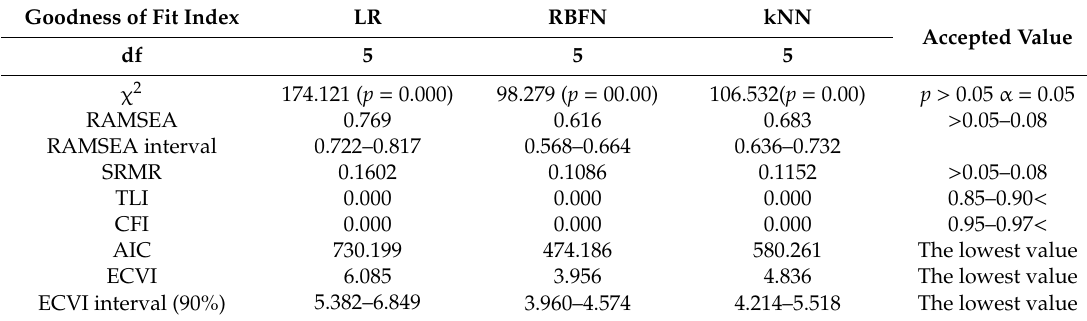
Table 4. Goodness-of-fit